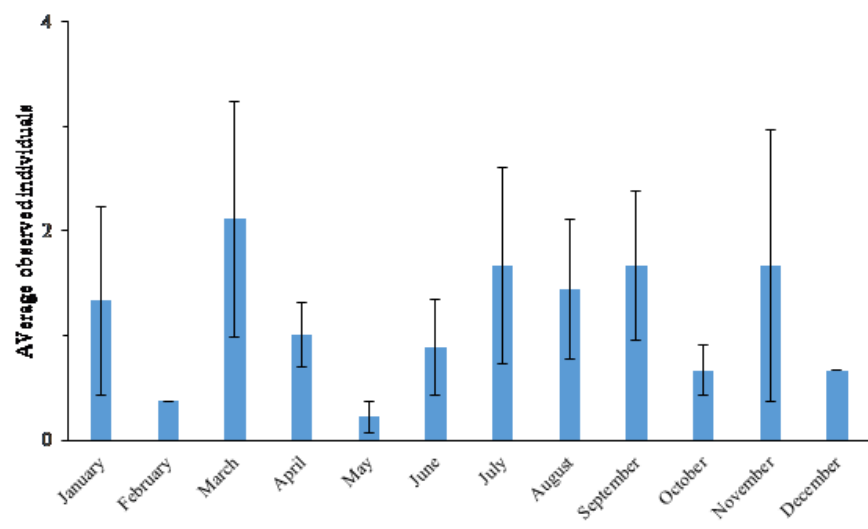
Figure 2. Average monthly observation (±ES) of Rana italica within studied caves. frog abundance among months ( F = 2.46, P = 0.005). March and November 11,704.58